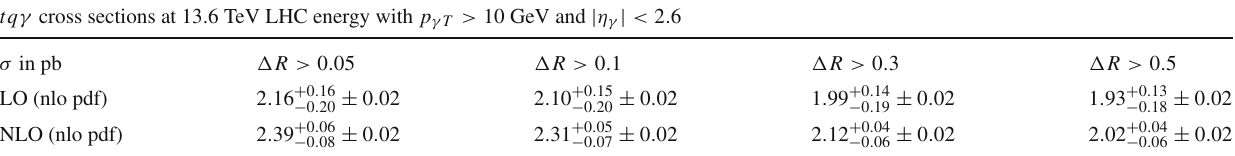
√ S = 13 . 6 TeV, with m t = 172 . 5 GeV and MSHT20 NLO pdf